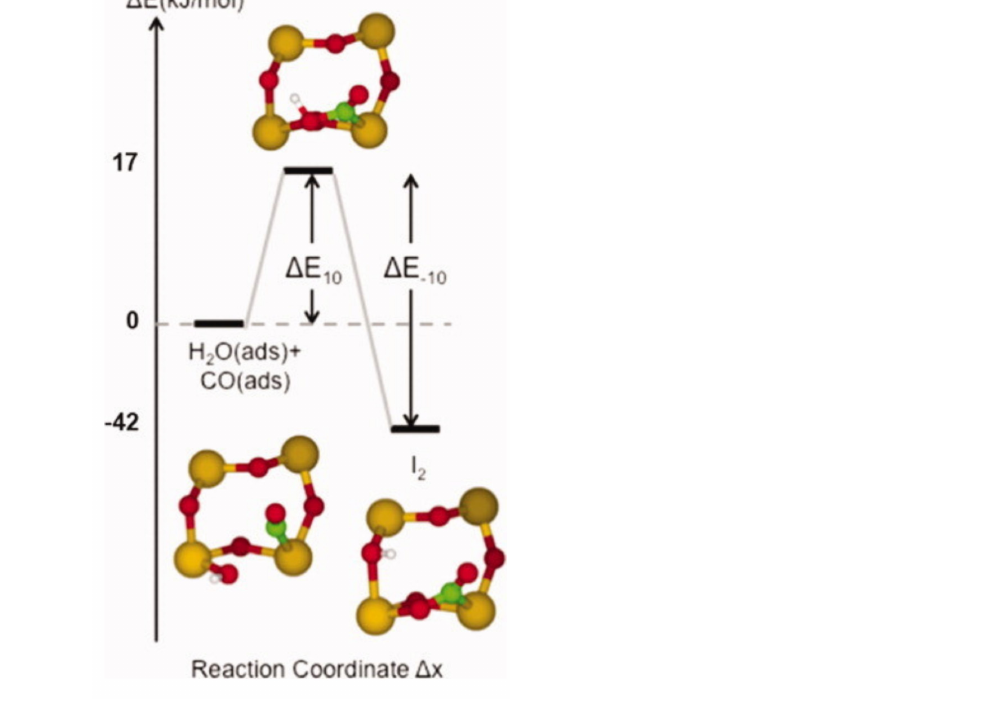
Figure 9. Adsorption of CO onto a (101) surface of SnO 2 with a terminal hydroxyl on an adjacent Sn 5c site. Reproduced with permission from Reference